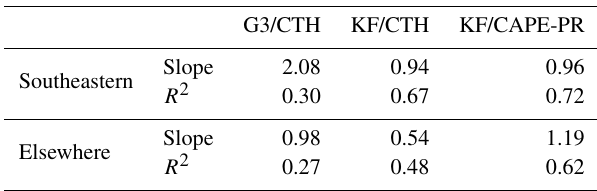
Table 1. Correlation statistics between observed and